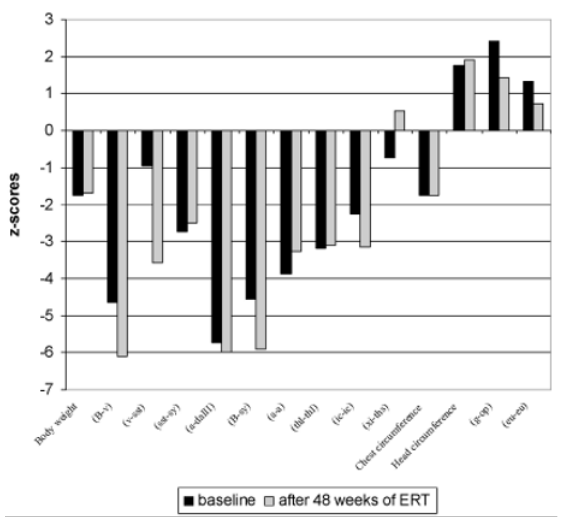
Figure 4. Z-scores values of anthropometric features of the patient with MPS VI. B-v: body height; v-sst: head and neck length; sst-sy: trunk length; a-daIII: upper extremities length; B-sy: lower extremities length; a-a: shoulders width, thl-thl: chest width; ic-ic: hip width; ths-xi: chest depth; g-op: head length; eu-eu: head breadth. ties (z-score: -4.55) were shorter than in the healthy population. Narrowing of shoulders (z-score: -3.87), chest and hip was also observed. The value of her head circumference was between 90 th and 97 th percen- tile, and the value for head length was greater than in the healthy population.